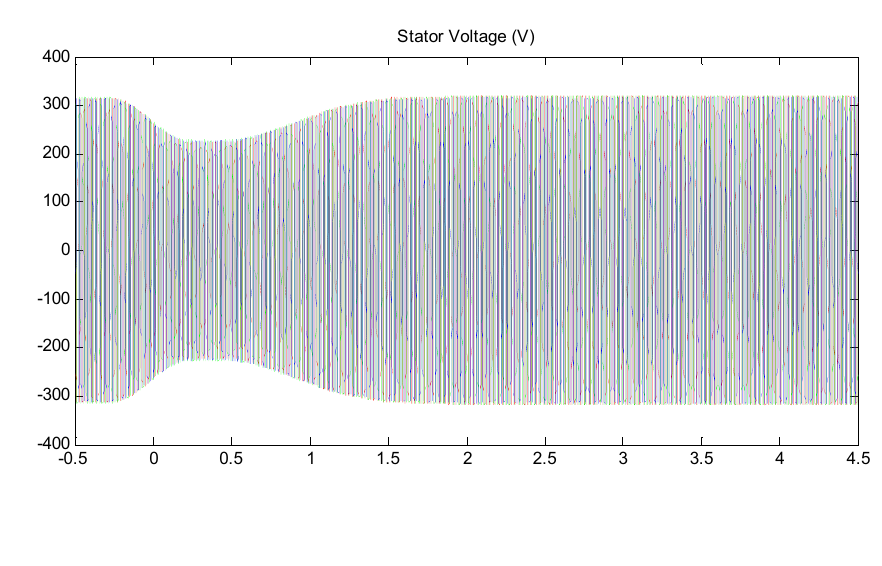
Figure 12. Grid voltage, (V) vs. time,